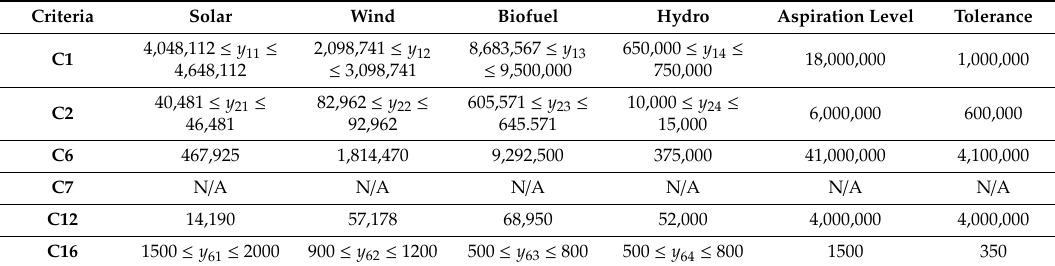
Table 5. Crisp criteria values and